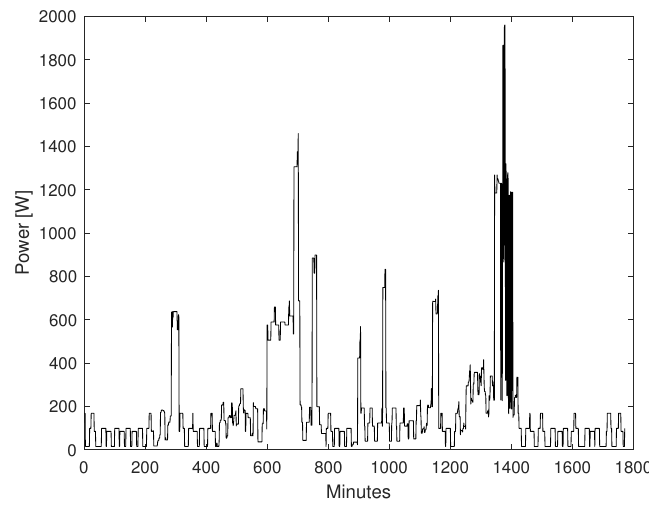
Figure 6. Thirty-hour household consumption power